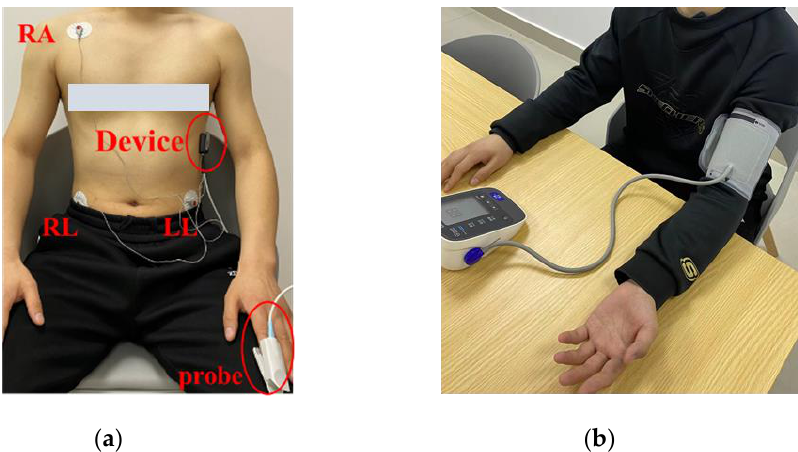
Figure 2. Data acquisition process. ( a ) Device wearing display, ( b ) BP measured by OMROM HEM- 7211.